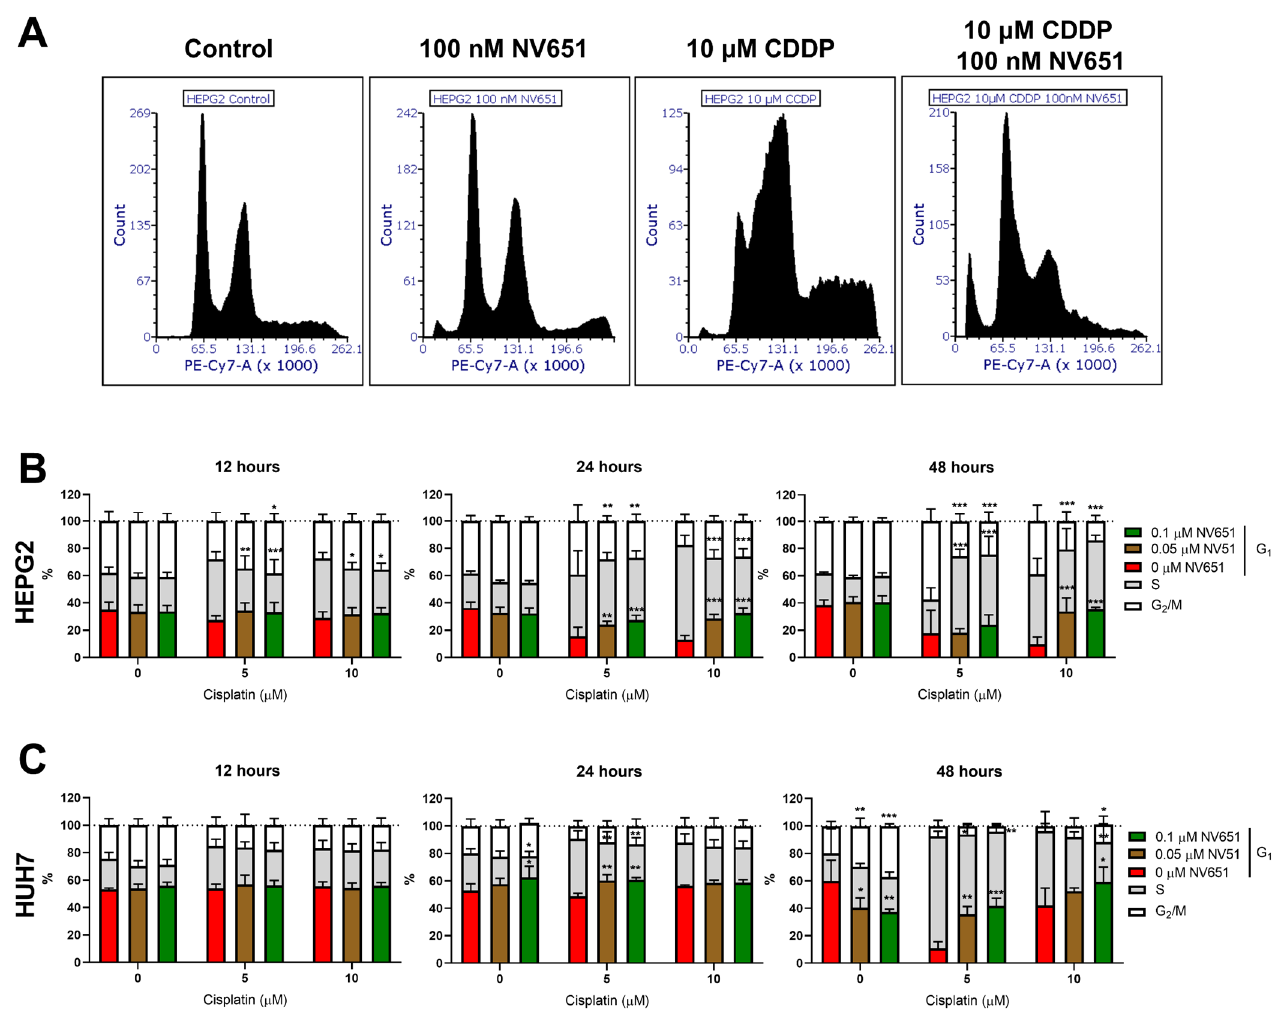
Figure 6. Effects of NV651 and cisplatin on the cell cycle. DNA content was analysed with PI staining in HEPG2 and HUH7 after treatment exposure for 12, 24 or 48 h. ( A ) Representative histograms of HEPG2 at 48 h of exposure; ( B , C ) G 1 , S and G 2 /M quantification analysed by 2-way ANOVA, followed by Dunnet’s multiple comparison test, with n = 3–5 biological replicates. Data are presented as the mean ± SD * p < 0.05, ** p < 0.01 and *** p < 0.001.